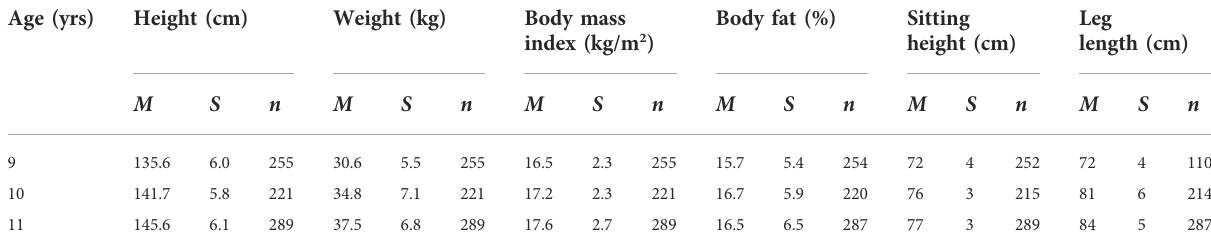
Body fat percentage: on the upper arm, scapulae, abdomen,